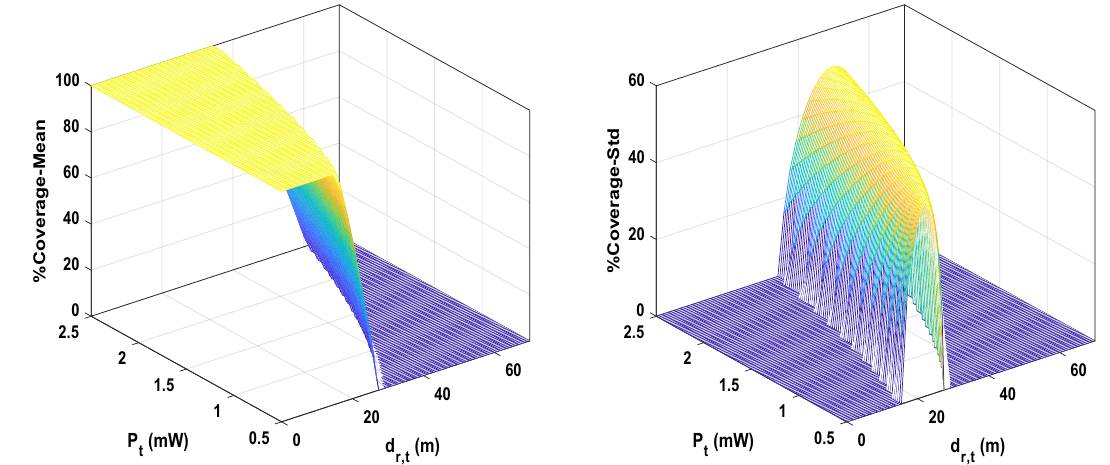
Figure 4. The 3D surface plot for 2,500 input combinations in crossed array design.